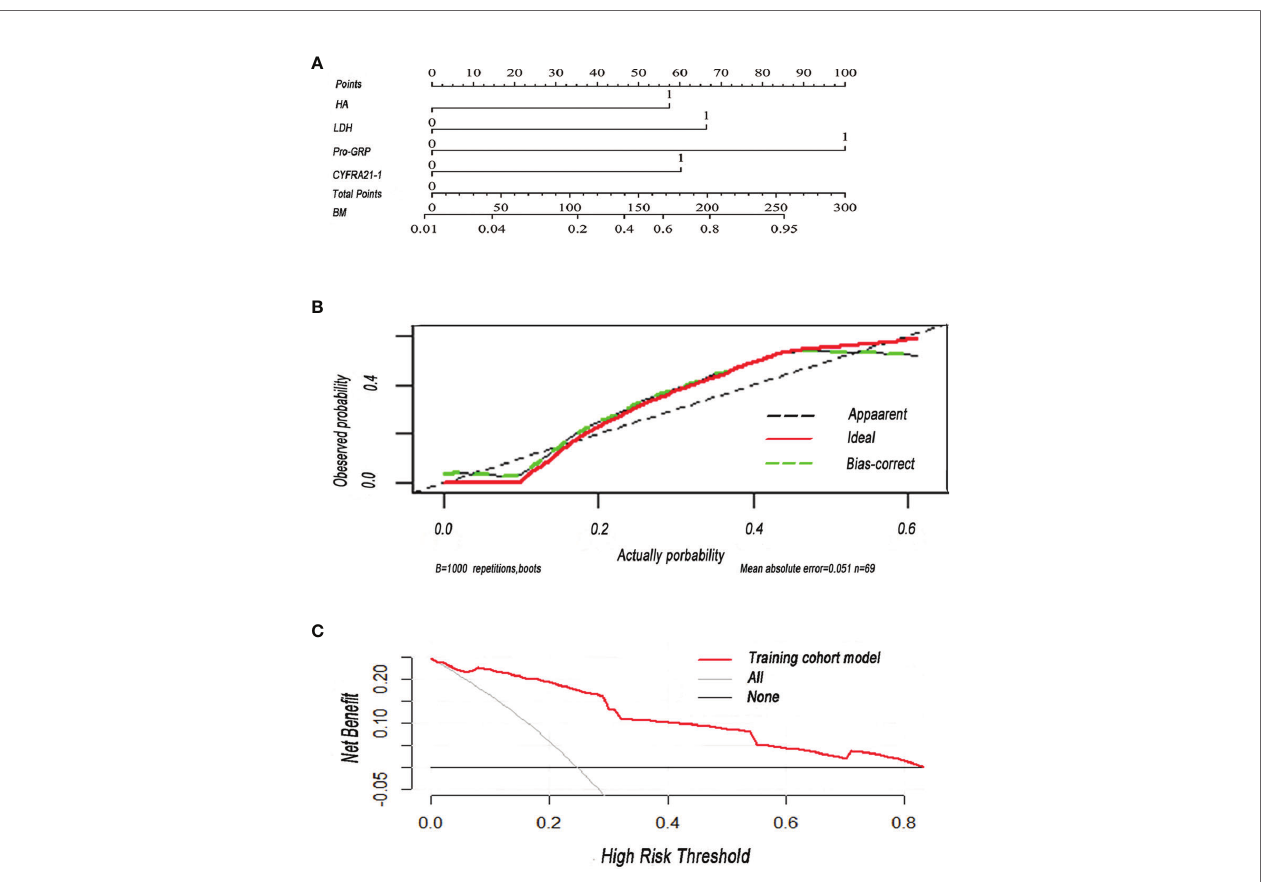
FIGURE 3 | (A) Nomogram was plotted for the prediction of BM in SCLC patients. The nomogram incorporated four items (HA, hyaluronan; LDH, lactate dehydrogenase; pro-GRP, pro-gastrin-releasing peptide; CYFRA21-1, cytokeratin 19 fragment 21-1). (B) Calibration curve of the nomogram for the prediction of BM. (C) Decision curve analysis of the nomogram was conducted to predict the chance of BM in SCLC. Red solid line: prediction model in the training cohort. Gray slash line: assumption that all patients have BM. Solid horizontal line: assumption that no patient has BM.